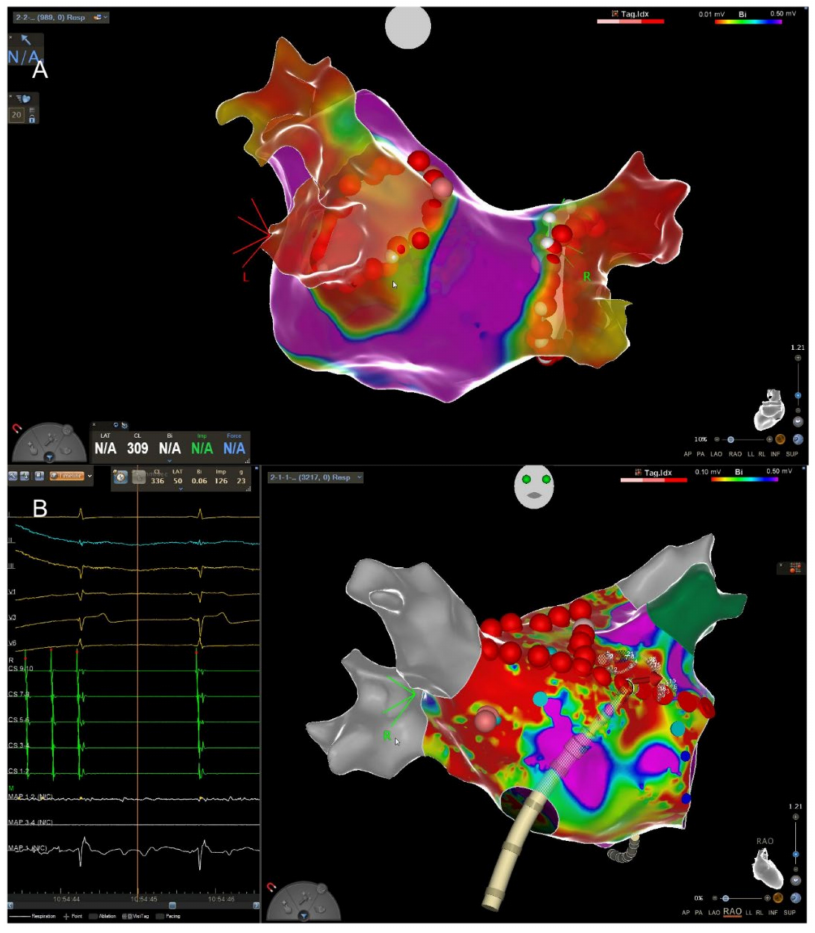
Figure 1. ( A ) High-density 3D map of the left atrium (LA) after pulmonary vein isolation (PVI). View from posterior to anterior. The red dots depict the ablation line encircling the right and left pulmonary veins. The red color indicates that the veins are isolated, and the violet color corresponds to healthy myocardium. ( B ) Termination of atypical flutter through application of a septal line connecting the mitral annulus with the right superior pulmonary vein (RSPV) depicted in grey. The real-time ECG on the left shows the termination into stable sinus rhythm. In contrast to ( A ), the LA shows extensive fibrosis (green = left atrial